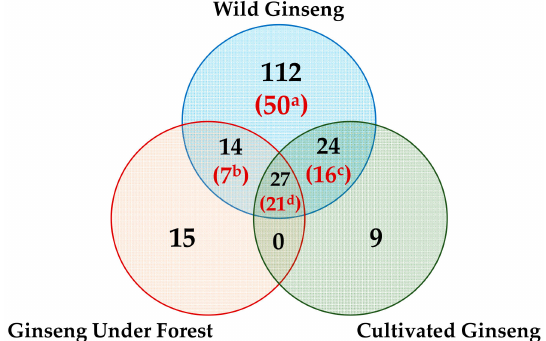
Figure 3. Saponins identified from each ginseng type only, two types of ginseng, or all the three types of ginseng via HPLC-IT-TOF-MS n (wild ginseng was samples nos. 19 and 20 combined, ginseng under forest was sample no. 18, and cultivated ginseng was sample no. 25; a, 112 saponins detected from at least one of the two W-GS with 50 saponins detected from both the two W-GS; b, 14 saponins detected from F-GS and at least one of the two W-GS with seven saponins detected from F-GS and both the two W-GS; c, 24 saponins detected from C-GS and at least one of the two W-GS with 16 saponins detected from C-GS and both the two W-GS; d, 27 saponins detected from C-GS, F-GS, and at least one of the two W-GS with 21 detected from C-GS, F-GS, and both the two